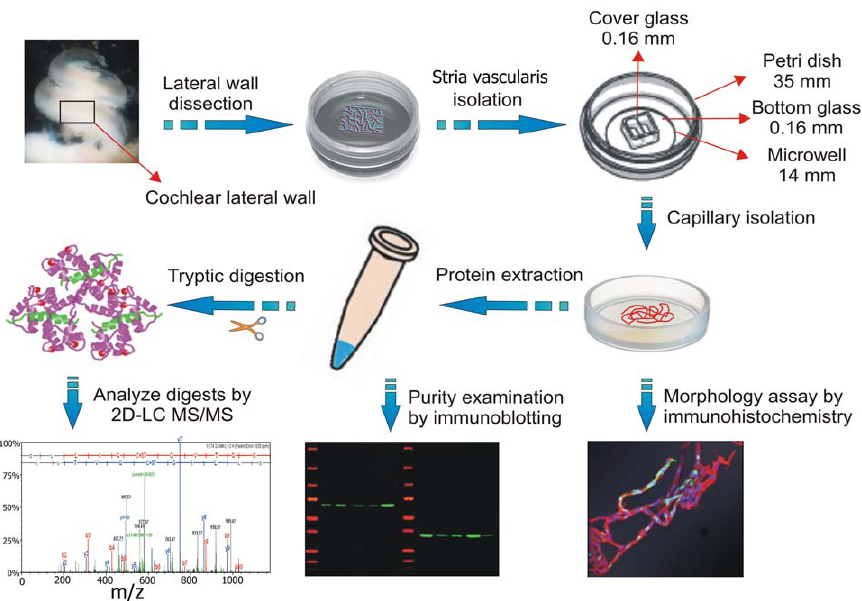
Figure 1. Isolation of capillaries from the stria vascularis of adult mouse cochlea. Flow diagram of the steps involved in capillary isolation from the stria vascularis and downstream processing for immunohistochemistry, immunoblot, and 2D-LC MS/MS analysis.